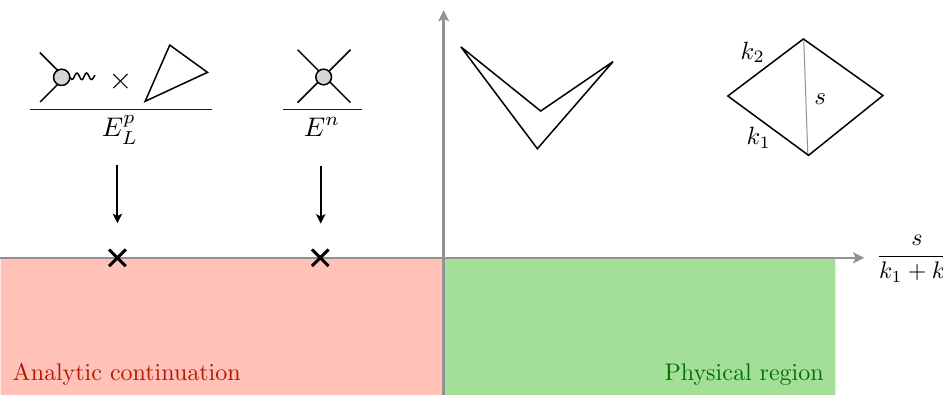
Figure 1. A one-dimensional slice through a four-point correlation function. Singularities in the unphysical region (where some of the energies have been analytically continued to negative values) determine the form of the correlator in the physical